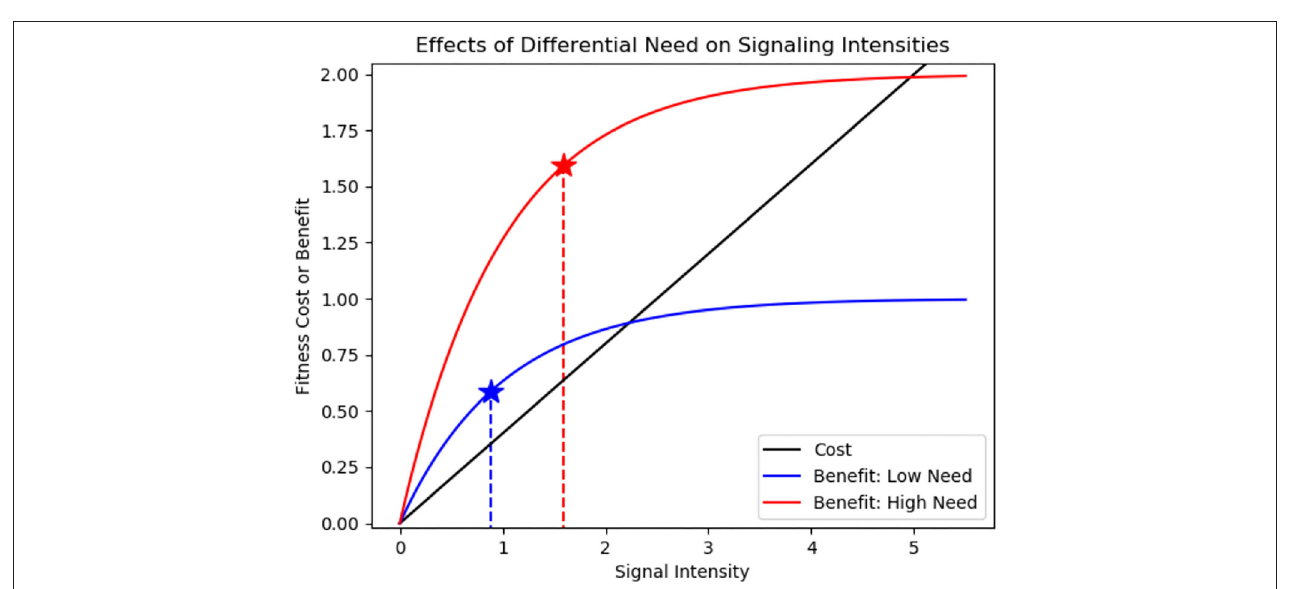
FIGURE 2 | Higher signaling benefits support higher signal intensities for needy signalers (inspired by Johnstone, 1977). The black curve represents the fitness cost of signaling for signalers. The blue curve represents the fitness benefit of signaling for a low need signaler: the benefits of signaling quickly saturate with signal intensity. The red curve represents the fitness benefit of signaling for a high need signaler: the benefit of signaling saturates more gradually with signal intensity. Signalers will signal at an intensity that maximizes the difference between cost and benefits (indicated by blue and red stars). Because the benefit curve saturates less quickly for high need signalers, the intersection point will occur at a higher signal intensity.